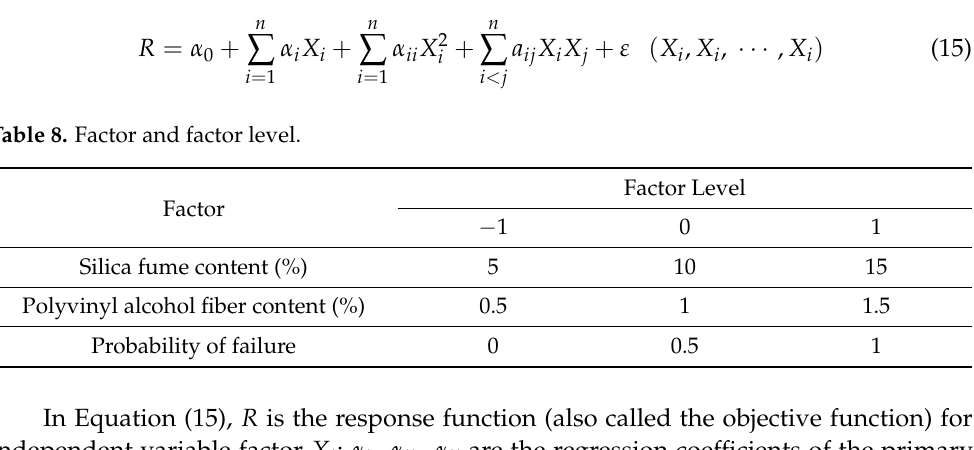
Table 8. Factor and factor level.